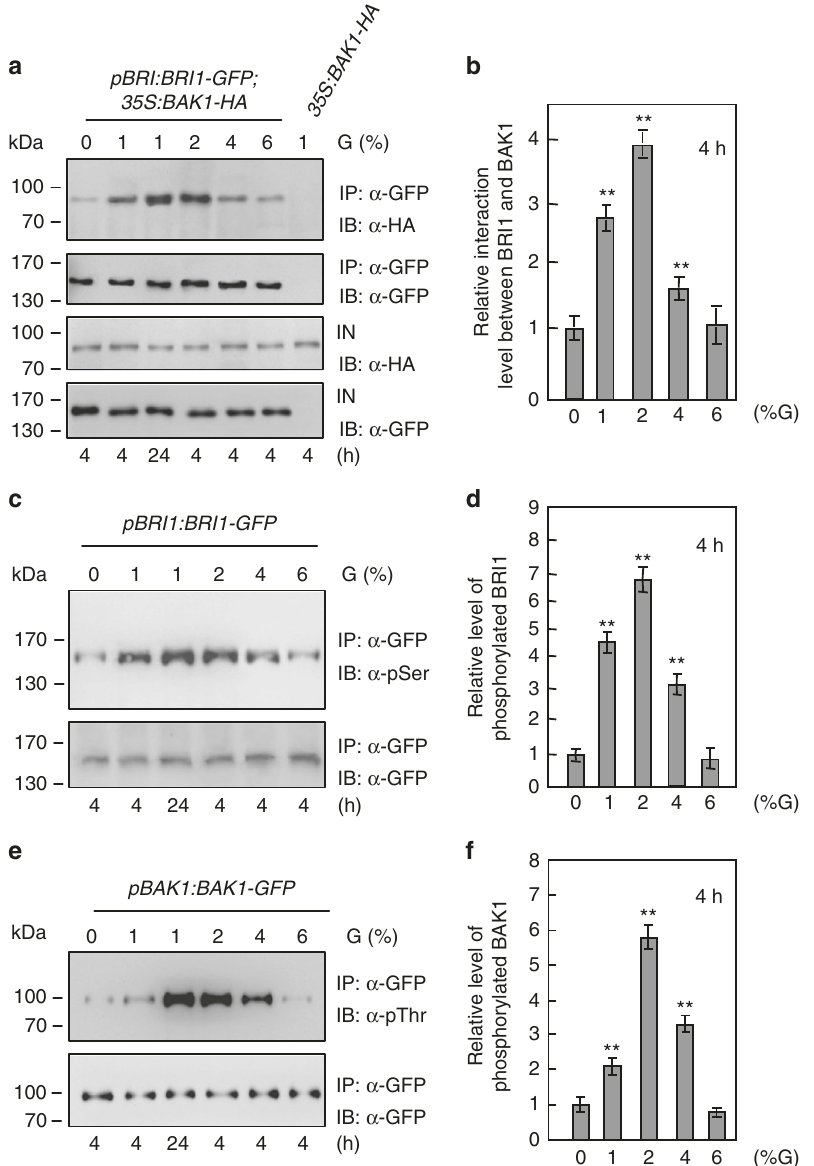
Fig. 2 Glucose in fl uences the interactions between BRI1 and BAK1. a Glucose regulates the physical interactions between BRI1 and BAK1. pBRI1:BRI1-GFP ; 35S: BAK1 - HA or 35S:BAK1-HA seedlings were grown in the light for 5 days, then incubated in darkness for 4 days, and treated with different concentrations of glucose (G) for 4 or 24 h. IN input; IP immunoprecipitation; IB immunoblot. b Quanti fi cation of BRI1-GFP and BAK1-HA associations in Arabidopsis seedlings treated with different concentrations of glucose (G) for 4 h from a . The ratio value of immunoprecipitated BAK1-HA to input BAK1-HA in response to 0% glucose was set at 1. Values for glucose treatments are given as mean ± SD ( n = 3). ** P < 0.01 compared with the value for 0% glucose treatment by Student ’ s t -test. c Glucose in fl uences the phosphorylation levels of BRI1 in Arabidopsis. pBRI1:BRI1-GFP seedlings were grown in the light for 5 days, then incubated in darkness for 4 days, and treated with different concentrations of glucose (G) for 4 or 24 h. IN input; IP immunoprecipitation; IB immunoblot. d Quanti fi cation of BRI1-GFP phosphorylation in Arabidopsis seedlings treated with different concentrations of glucose for 4 h from c . The ratio value of phosphorylated BRI1-GFP to immunoprecipitated BRI1-GFP in response to 0% glucose was set at 1. Values for glucose treatments are given as mean ± SD ( n = 3). ** P < 0.01 compared with the value for 0% glucose treatment by Student ’ s t -test. e Glucose in fl uences the phosphorylation levels of BAK1 in Arabidopsis. pBAK1:BAK1-GFP seedlings were grown in the light for 5 days, then incubated in darkness for 4 days, and treated with different concentrations of glucose (G) for 4 or 24 h. IN, input; IP immunoprecipitation; IB immunoblot. f Quanti fi cation of BAK1-GFP phosphorylation in Arabidopsis seedlings treated with different concentrations of glucose for 4 h from e . The ratio value of phosphorylated BAK1-GFP to immunoprecipitated BAK1-GFP was set at 1. Values for glucose treatments are given as mean ± SD ( n = 3). ** P < 0.01 compared with the value for 0% glucose treatment by Student ’